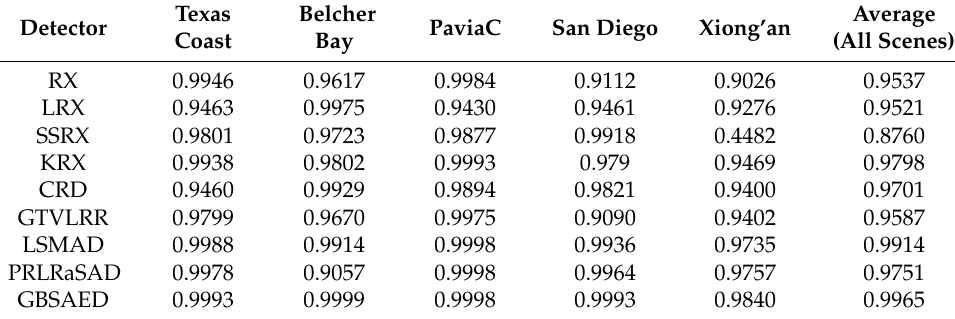
Table 2. AUC values of each algorithm for five